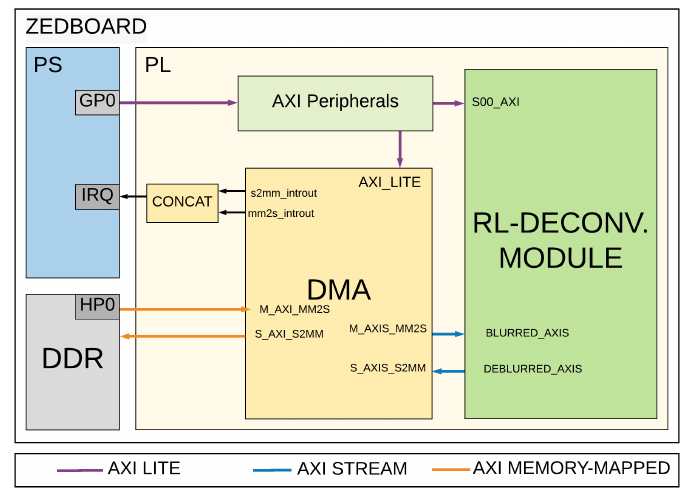
Figure 18. The overall SoC with RL deconvolution module.